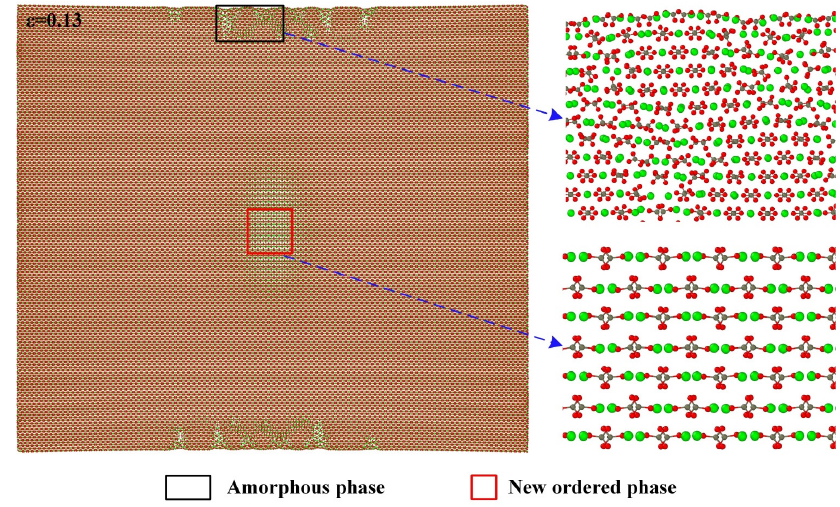
Figure 6. Partial enlarged details of atomic configuration at strain of 0.13 along the [010] direc- tion.